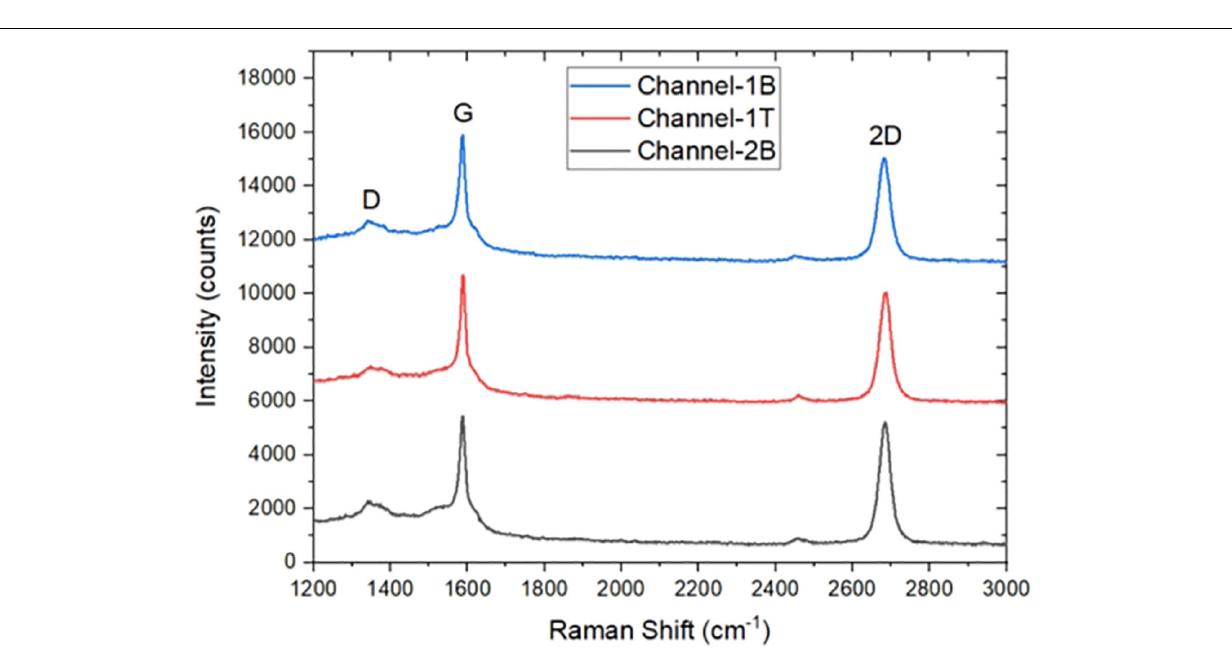
FIGURE 3 | Steps for GFET functionalisation (A) bare graphene, (B) annealed graphene (showing evaporation of water molecules), (C) attachment of Pyr-NHS ester molecules with graphene, (D) anti-Clusterin antibody attachment to linkers (red), (E) BSA blocking (purple), and (F) binding of Clusterin (tri-colour molecules) with the anti-Clusterin